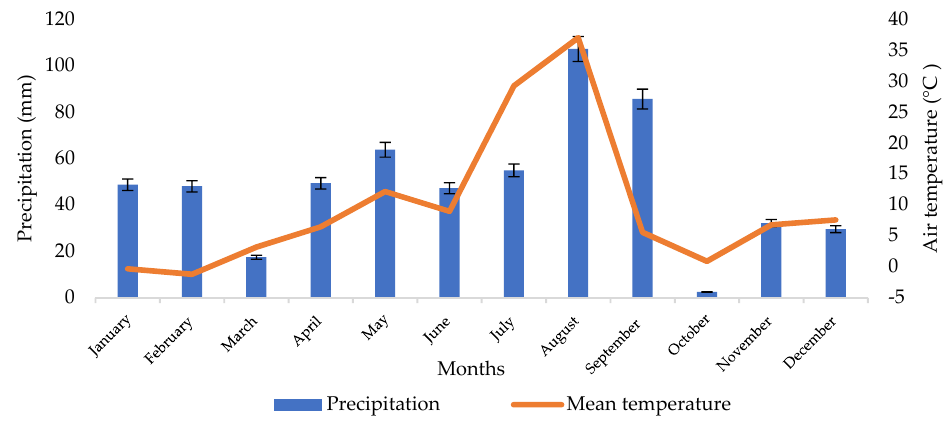
Figure 1. Data on weather conditions in 2021 provided by the meteorological Station of the University of Rzeszow.